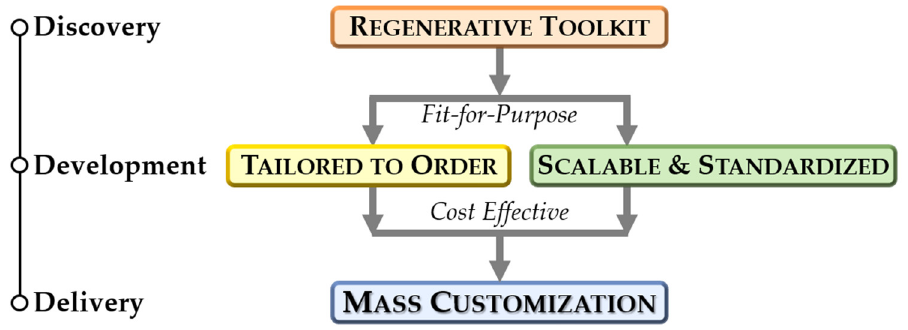
Figure 3. Mass customization, an imperative in attaining sustainable and democratized regenerative care, requires a fit-for-purpose streamlining of a diverse innovation toolbox to develop a cost-effective supply of made-to-order, scalable, and standardized regenerative products.